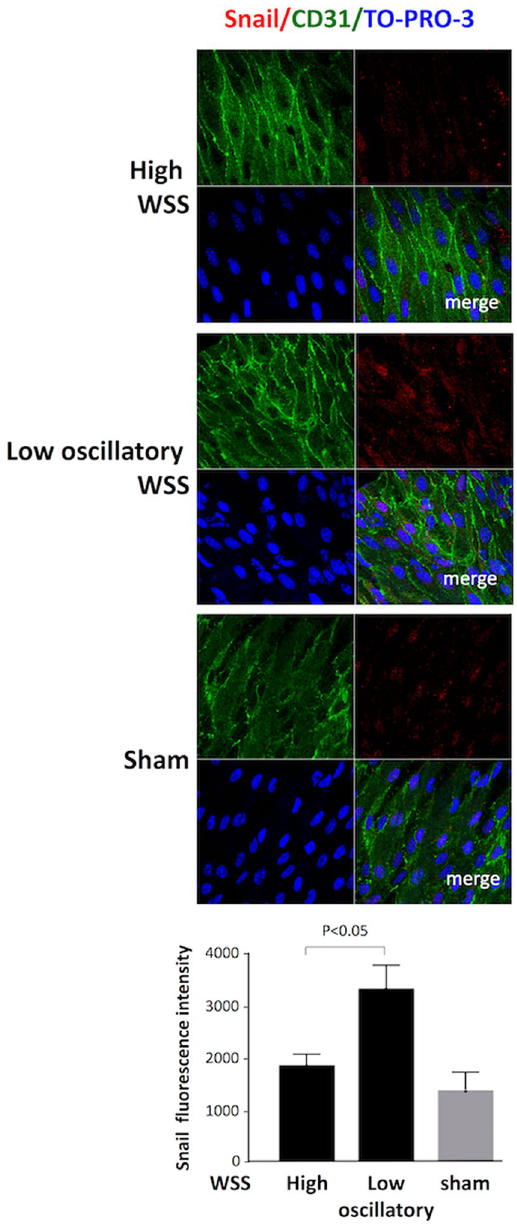
Figure 5. Snail was induced by low oscillatory shear stress in murine carotid arteries. Flow-altering, constrictive cuffs were placed on the right carotid arteries of C57BL/6 mice. They generated anatomically distinct regions exposed to high or low oscillatory wall shear stress (WSS; as indicated). Contralateral arteries were used as an experimental control. Experimental arteries were harvested after 14 days and en face staining was performed using anti-Snail antibodies (red), anti-CD31 antibodies (green) and the nuclear counter stain TO-PRO-3 (blue). Representative images (scale bar, 10 μ m) and quantitation of Snail expression (n = 3; mean + / − SEM) are